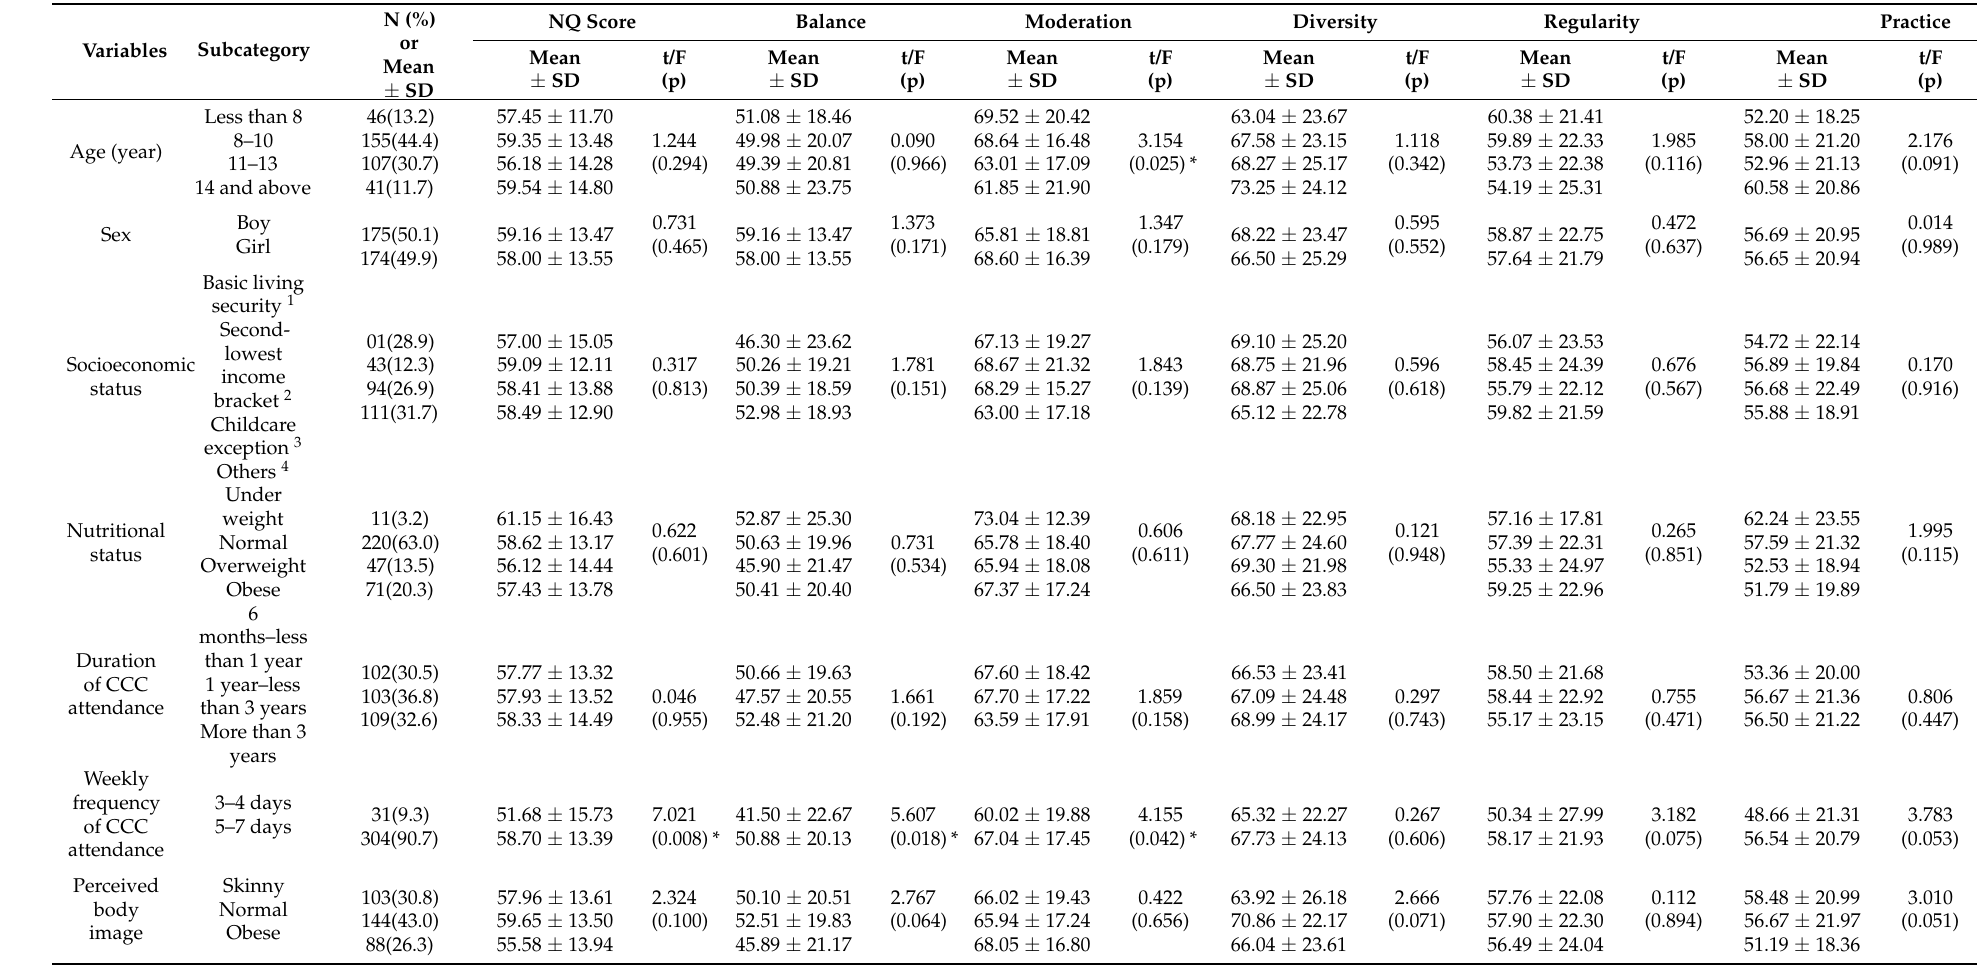
Table A3. Sub-group analysis of NQ scores according to children’s general characteristics. N =